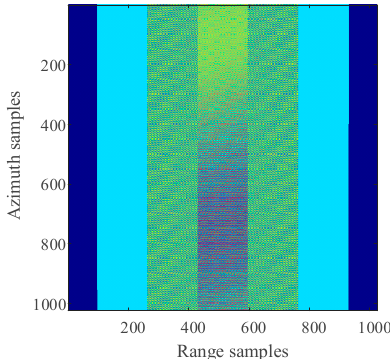
Figure 7. The Schematic diagram of azimuth full sampling echo data.